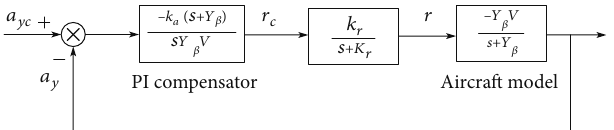
Figure 11: Diagram of the lateral acceleration control.